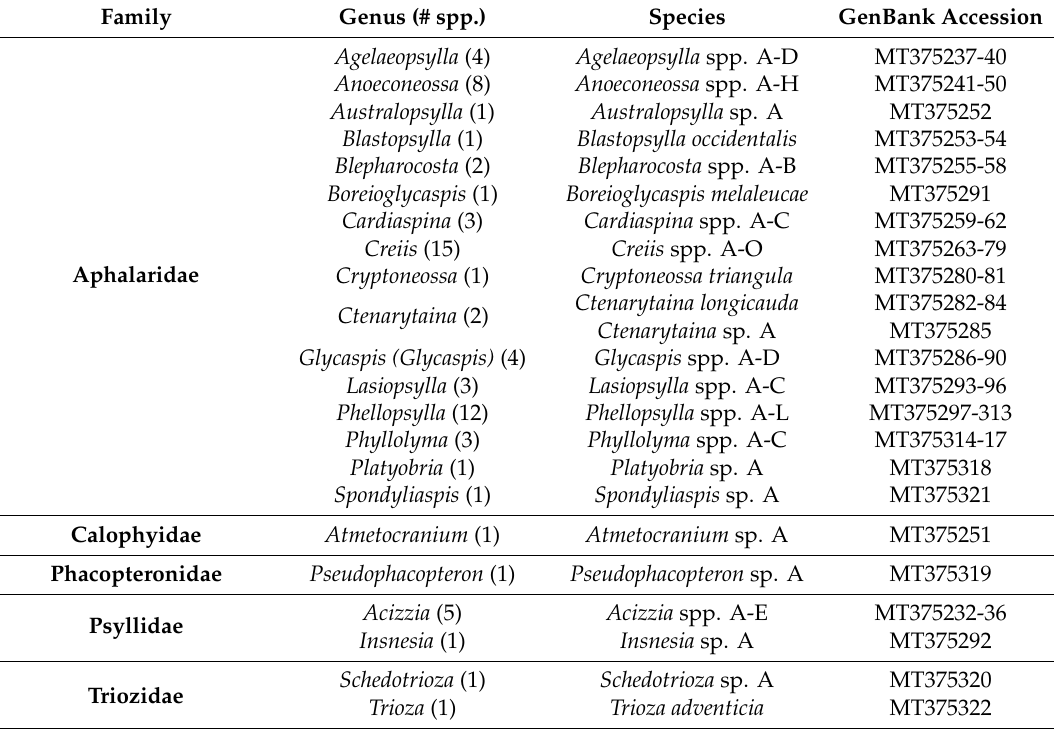
Table 2. Final psyllid sample identifications. Combined morphology and DNA barcoding results for 72 taxa collected. Additional details are in Table S1.